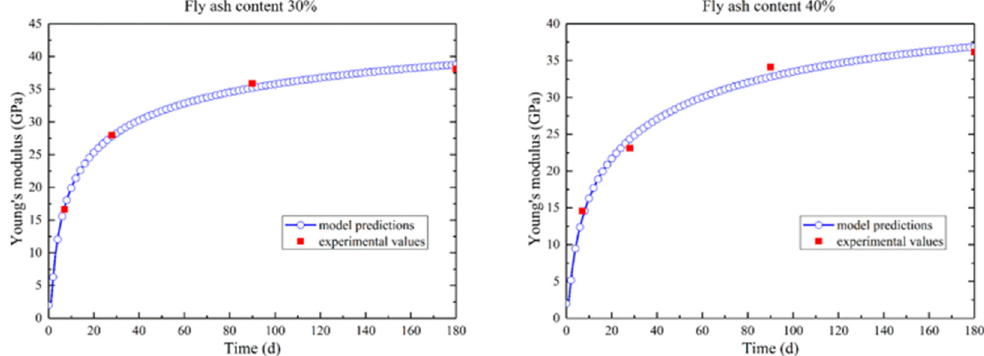
Figure 3. Young’s modulus evolution of magnesium oxide concrete (fly ash content 30% and 40%) under adiabatic conditions.